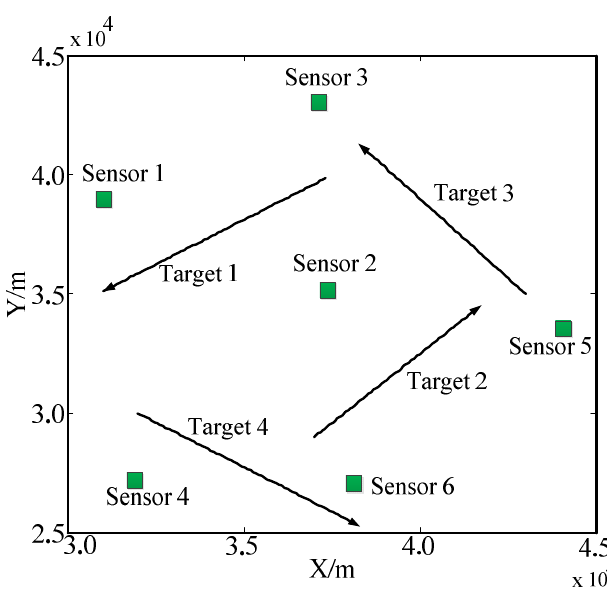
Figure 13. Sensor positions and target trajectories.